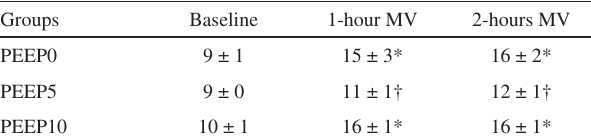
Table 1 - Mean values and standard deviations of tracheal peak pressure at the baseline, and after one and two hours of mechanical ventilation (*, p<0.05 vs. baseline; †, p<0.05 vs. other groups at the same time points)